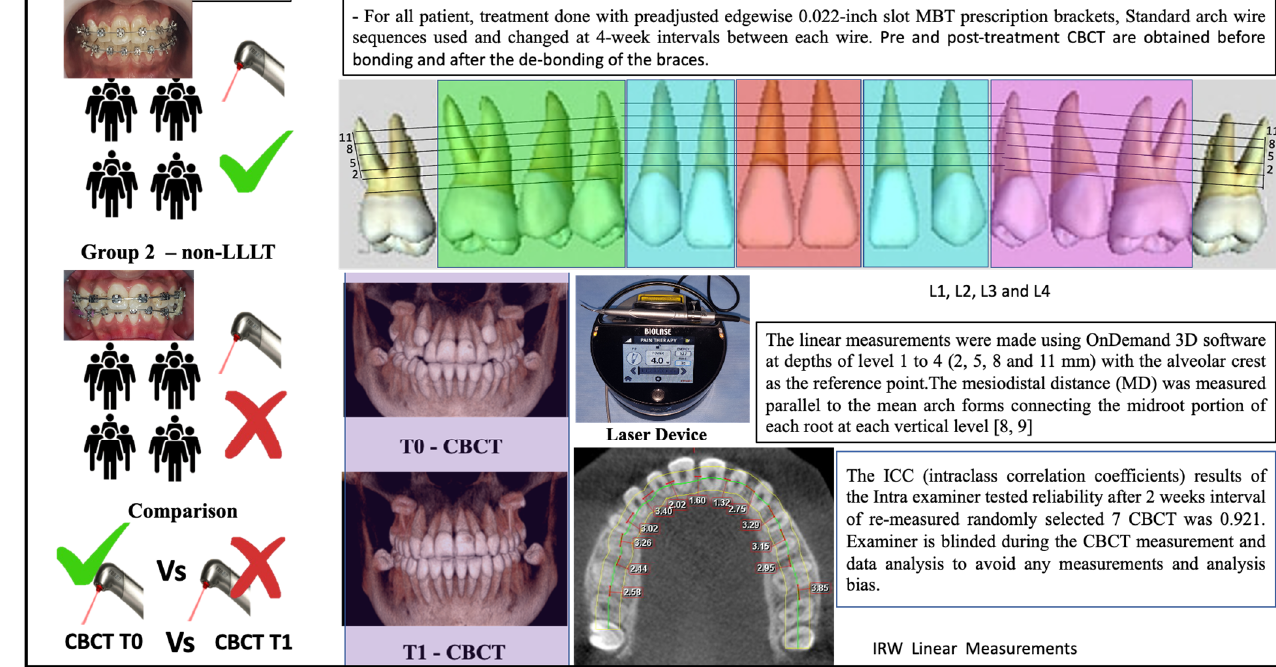
Figure 3A. At T0, T1, and T0 vs. T1 CBCT, the data of all four levels are insignificant. Table 1. IRW of the maxilla (both sides) at various levels. LLLT and non-LLLT differences between pre- and post-treatment groups—middle quadrant teeth.